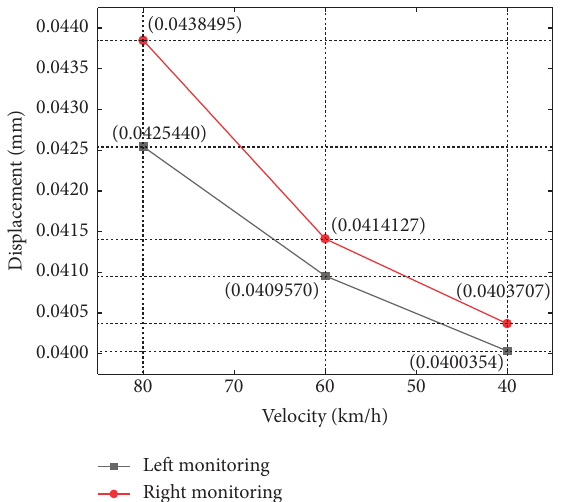
Figure 7: Comparison of maximum vertical displacement of track under different train velocities.